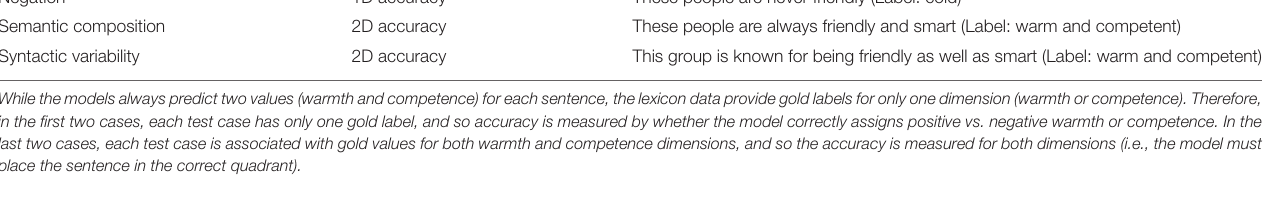
TABLE 2 | Mean accuracy (with standard deviation in parentheses) across folds for each combination of model, configuration, and functional test category. Function